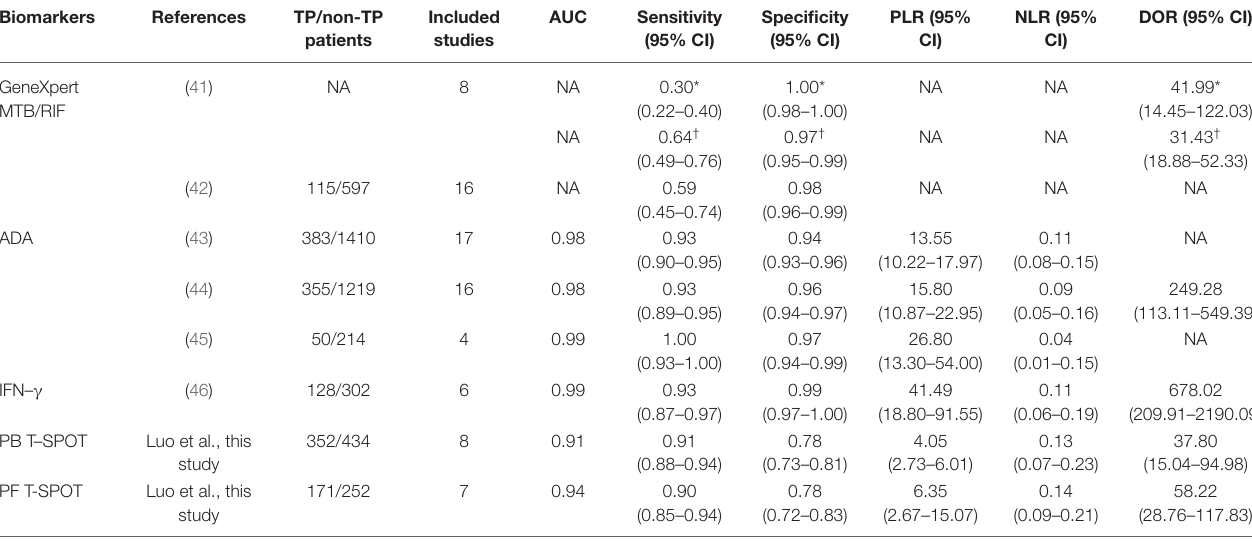
TABLE 4 | Meta-analyses assessing the performance of GeneXpert MTB/RIF, ADA, IFN- γ , and T-SPOT for diagnosing